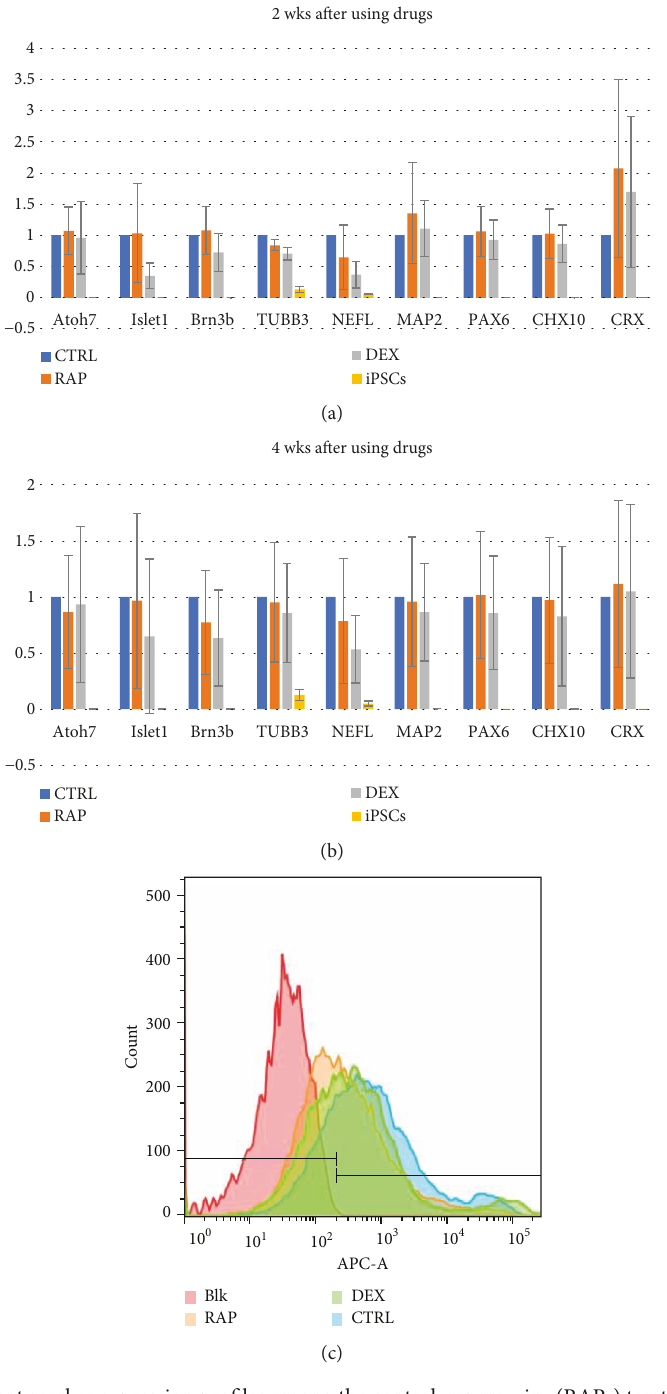
Figure 4: Comparisons of di ff erent marker expression pro fi les among the control, rapamycin- (RAP-) treated, and dexamethasone- (DEX-) treated groups. Two weeks after immunosuppressant treatment, (a) cells in the retinal organoids treated with RAP expressed higher levels of the retinal ganglion cell (RGC) markers Atoh7, Islet1, and Brn3b, the dendrite marker MAP2, the retinal progenitor marker PAX6 and CHX10, and photoreceptor marker CRX, compared to levels in the control group. These cells also expressed lower levels of the axon markers TUBB3 and NEFL than cells in the control group. In DEX-treatment group cells, dendrite, retinal progenitor, and photoreceptor markers (MAP2, CHX10, and CRX) were upregulated compared to levels in the control group. (b) However, 4 weeks after immunosuppressant treatment, both RAP- and DEX-treated cells showed higher expression levels of only PAX6 and CRX as compared to those in the control group. (c) Representative histogram of fl ow cytometry results. Each wave represented one group; the proportion of each group was calculated by the Blk group. There were 79 87 ± 5 92 % of the RGCs in the control group, 60 97 ± 7 36 % in the RAP group, and 63 6 ± 10 35 % in the DEX group. CTRL: control group; RAP: rapamycin-treatment group; DEX: dexamethasone-treatment group; iPSCs: negative control group in RT-PCR; Blk: blank control group in fl ow